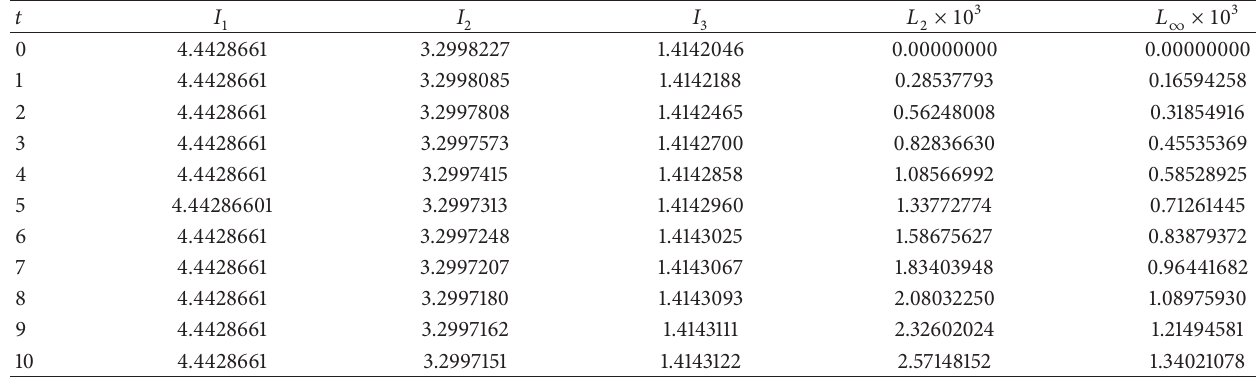
Table 1: Invariants and error norms for single solitary wave with 𝑐 = 1 , ℎ = 0.2 , 𝑘 = 0.025 , 0 ≤ 𝑥 ≤ 100 .